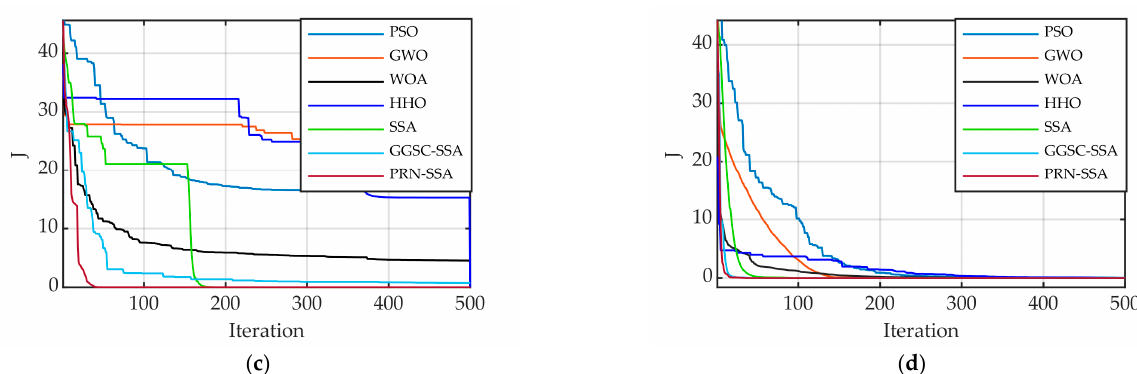
Figure 16. Parameter identification convergence curve: ( a ) Step (1); ( b ) Step (0.5); ( c ) Sinusoidal (2 π ); ( d ) Sinusoidal (0.5 π ).